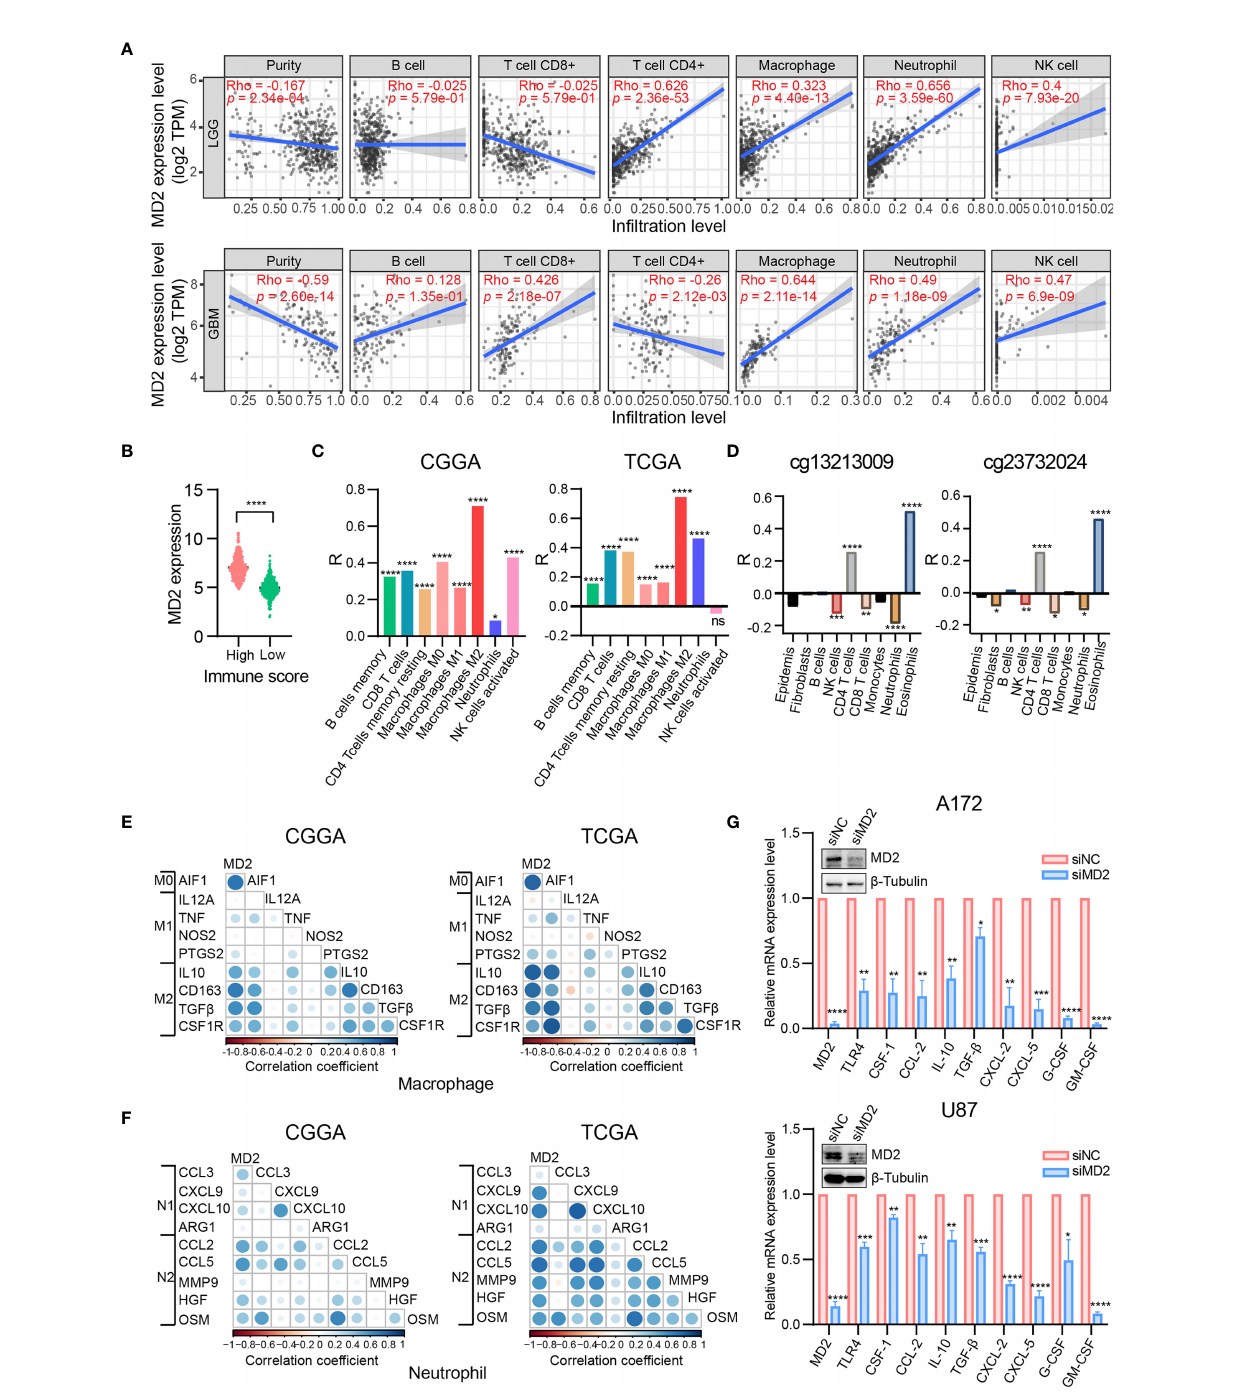
FIGURE 7 | Correlation analysis between MD2 expression and immune cells fi ltration. (A) The correlation of MD2 with the six types of immune cells fi ltration level in LGG and GBM based on the TIMER algorithm. (B) Comparison of MD2 expression between the high and low immune score groups of gliomas. (C) The correlation between MD2 and eight types of immune cells and subpopulations fi ltration level in CGGA and TCGA datasets based on CIBERSORT algorithm. (D) The correlation between the MD2 DNA methylation and nine types of immune cells fi ltration levels. (E) The correlation between MD2 and classical phenotype markers of M0, M1 and M2 in CGGA and TCGA databases. Color depth and circle square represent the degrees of correlation. (F) The correlation between MD2 and classical phenotype markers of N1 and N2 in CGGA and TCGA databases. Color depth and circle square represent the degrees of correlation. (G) qRT-PCR analysis of the cytokine mRNA expression after MD2 knockdown in U87 and A172 cells. *, **, *** and **** indicate p < 0.05, p < 0.01, p < 0.001 and p < 0.0001,